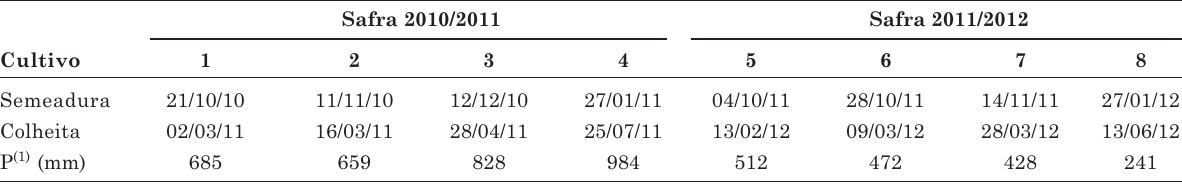
(1) P: precipitação pluvial acumulada desde a semeadura até a maturação fisiológica, obtida da estação meteorológica de superfície automática do IRDeR/DEAg, localizada a aproximadamente 500 m da área experimental, pertencente à rede de estações da